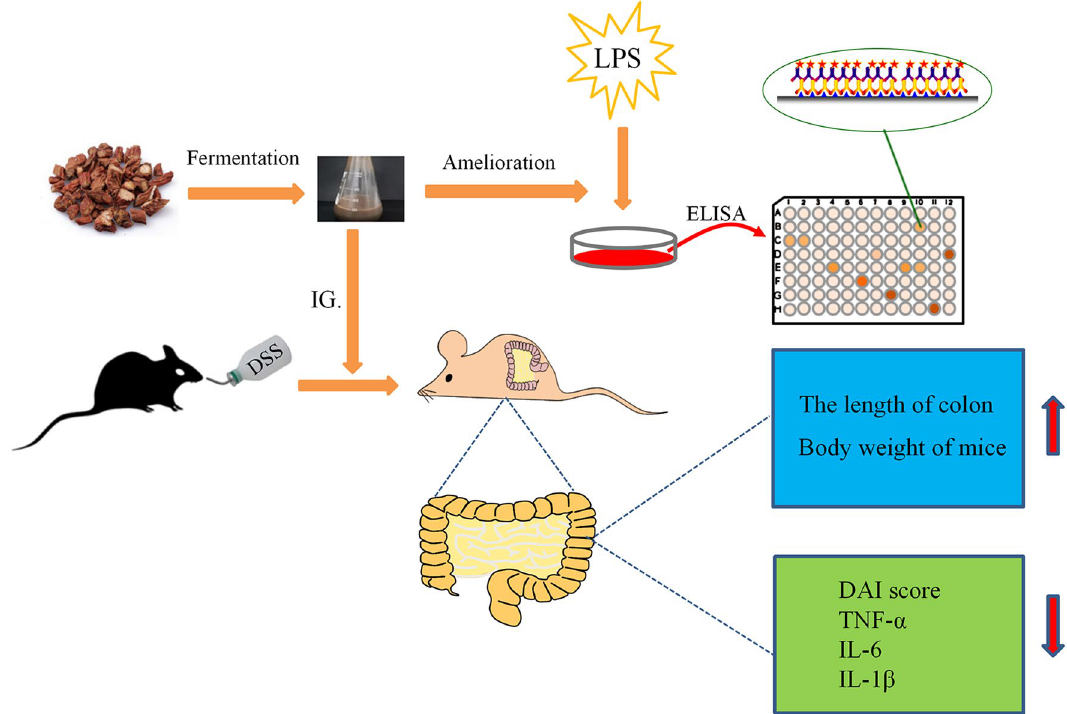
Figure 7. The diagram of the experimental procedure and results. Images were processed by use of Adobe Photoshop SC6 (6.1, https:// www. adobe. com/ cn/ produ cts/ photo shop. html) and Scienceslides 2016 (1.16.06.16, https:// www. visis cience. com/ scien cesli des) of Microsoft office professional plus 2013 (15.0.4420.1017, https:// www. micro soft. com/ zh- cn/ downl oad/ detai ls. aspx? id=